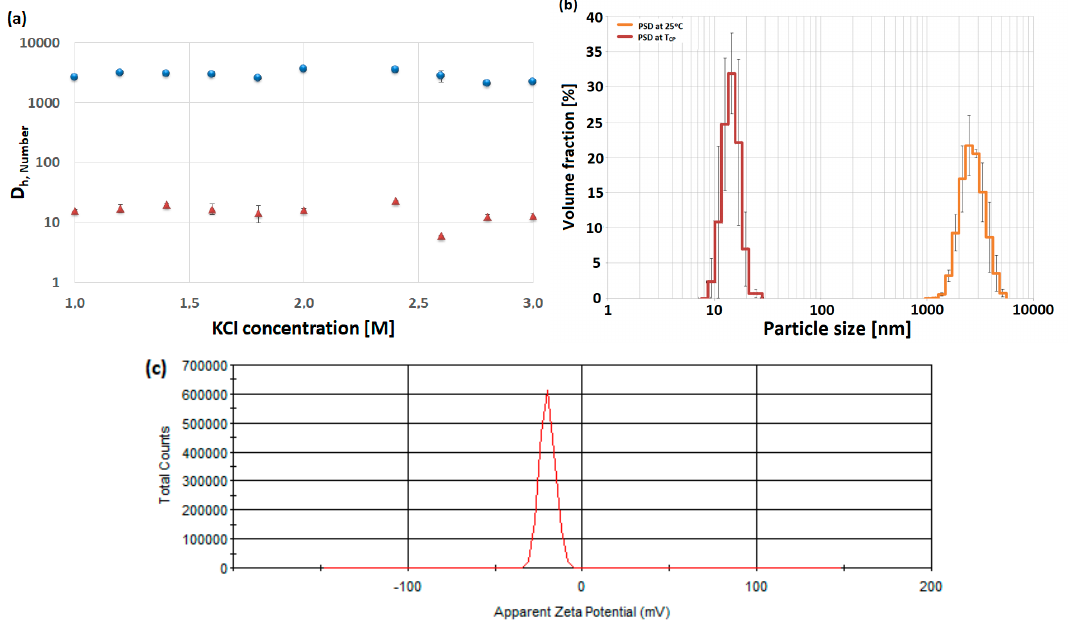
Figure 4. Hydrodynamic diameters ( D h ) of 0.25% L1 for various KCl concentrations at 25 °C (dots) and at T CP (triangles) ( a ); particle size distribution of 0.25% L1 in 3 M KCl solution at different temperatures ( b ); zeta potential (ZP) of 1% L1 in water at 25 °C ( c ).